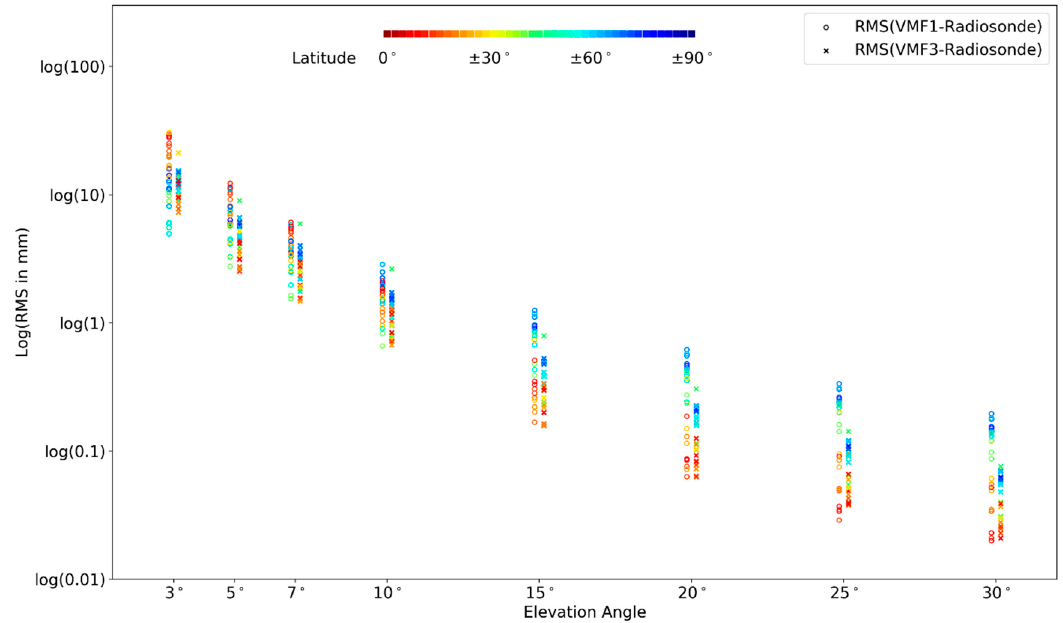
Figure 7. Root mean square (RMS) of VMF1 / VMF3 hydrostatic mapping function SHD estimates with respect to radiosonde + ISA76 SHD estimates obtained by ray-tracing in mm, for the 28 stations of this study, over 3 years (1 January 2016 to 31 December 2018). Cross marks stand for the VMF3 SHD estimates, and circle marks stand for the VMF1 SHD estimates (they are plotted with a small horizontal shift to avoid overlapping). The color bar indicates the station latitudes. Table 5. Mean RMS, biases, and standard deviations (STD) of the differences between the hydrostatic